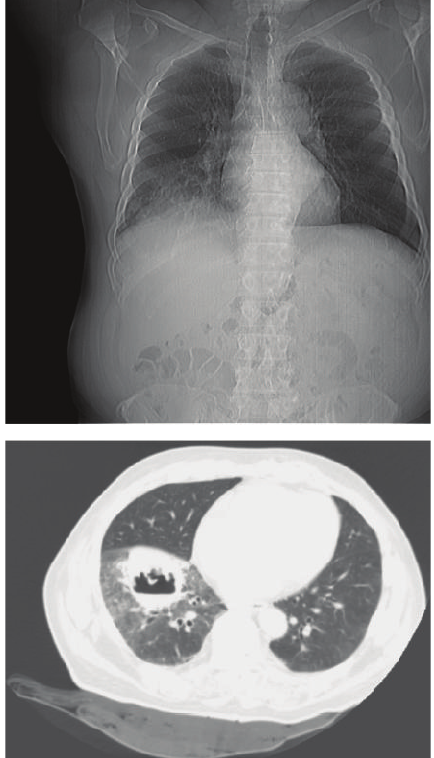
Figure 4: Rapid, major pulmonary infiltration by day six of